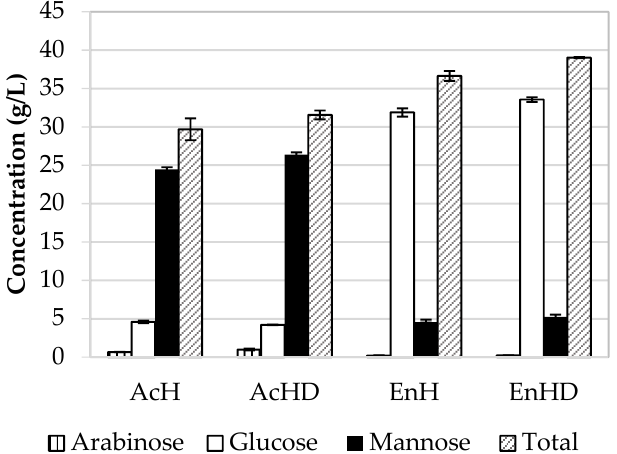
Figure 3. Monosaccharides obtained from optimal conditions for acid hydrolysis (AcH), acid hydrolysis of extracted bored-coffee beans (AcHD), enzymatic hydrolysis (EnH), and enzymatic hydrolysis of extracted bored-coffee beans (EnHD). Error bars represent ± standard deviations (n = 2). of extracted bored-coffee beans (EnHD); this treatment resulted in glucose as the main hydrolyzate (33.5 g/L), mannose was found at 5.2 g/L, and arabinose was found in even lower quantities (0.19